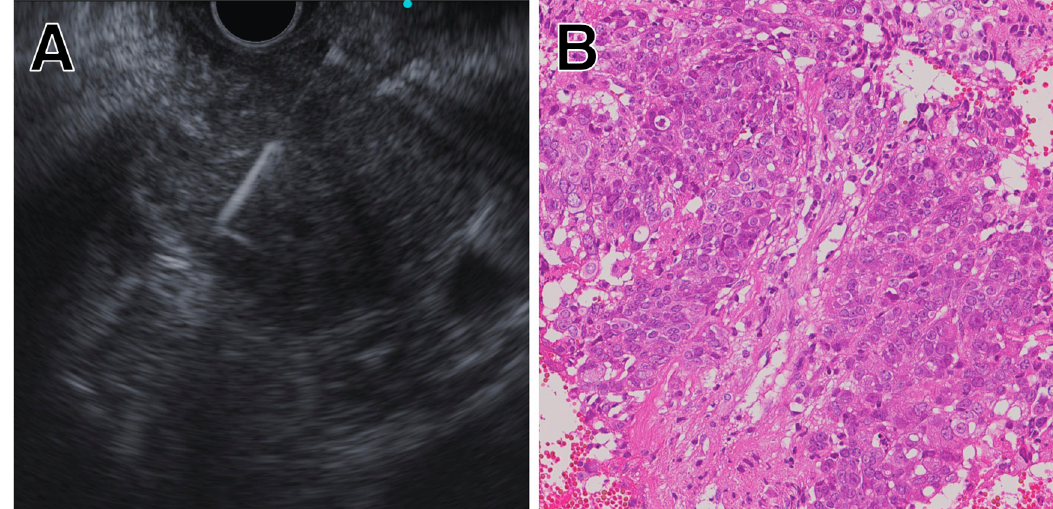
Figure 2. Representative case of Endoscopic Ultrasound-Guided Tissue Acquisition (EUS-TA) for pancreatic cancer (PC). ( A ) Endoscopic ultrasound-guided fine needle biopsy (EUS-FNB) of PC located in the body of the pancreas. ( B ) Tissue sample obtained by EUS-FNB showing large tissue fragments of poorly differentiated adenocarcinoma.